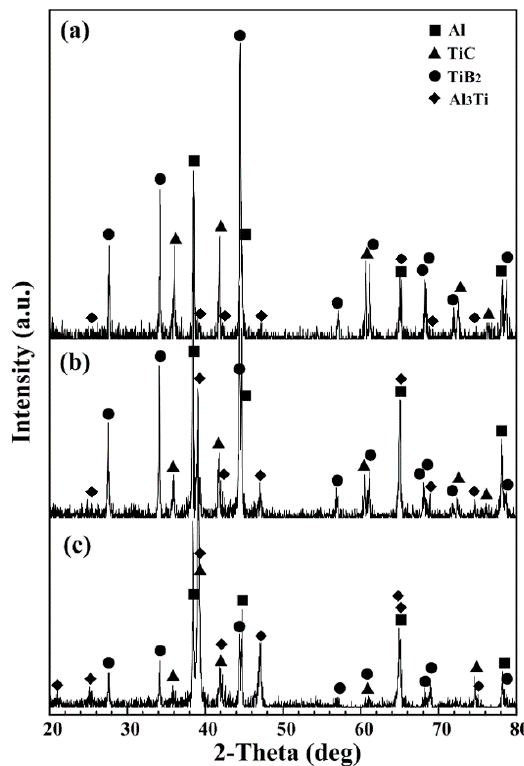
Figure 5. Phase identification of bionic layered composite ( a ) outer layer ( b ) middle layer ( c ) inner layer.